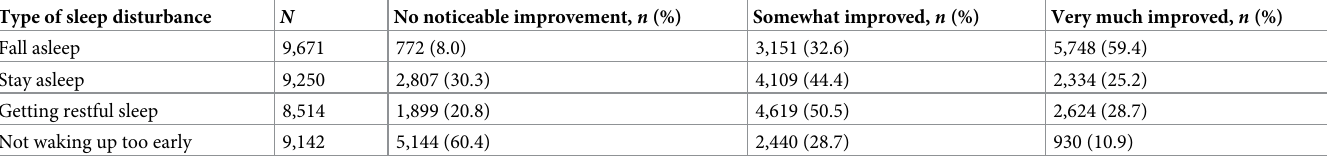
Table 4. Frequencies of reported improvements in sleep